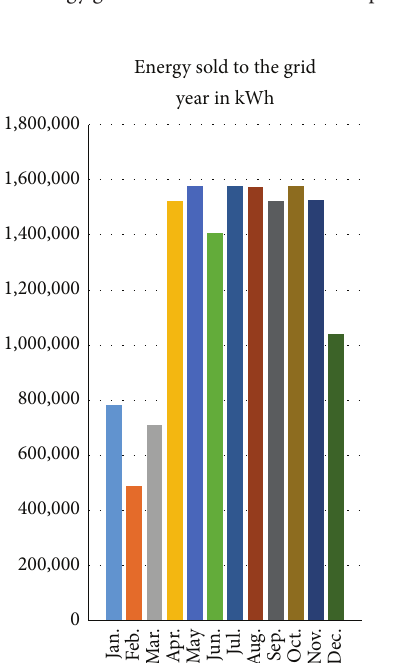
Figure 13: Energy generated versus load demand per year.